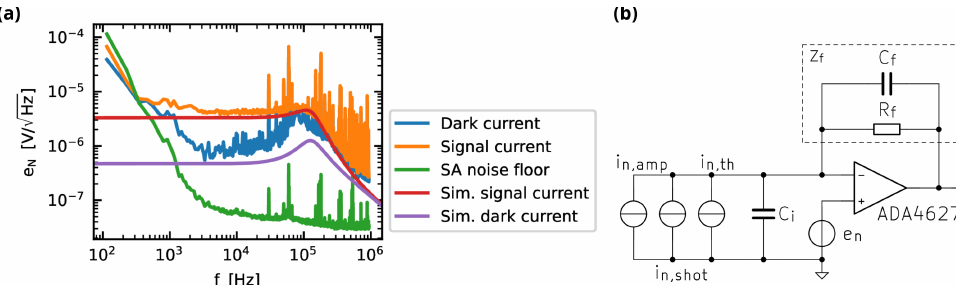
Figure A2. ( a ) Output noise spectral density of the TIA at signal current and dark current. The signal analyzer’s noise floor dominates below 1 kHz. ( b ) Equivalent circuit showing individual noise current sources for the amplifier input current noise i n,amp , shot noise due to signal and dark current i n,shot and thermal noise of R f i n,th . The input voltage noise is modeled in the non-inverting input of the OPA. All parasitic input capacitances are included by C i .